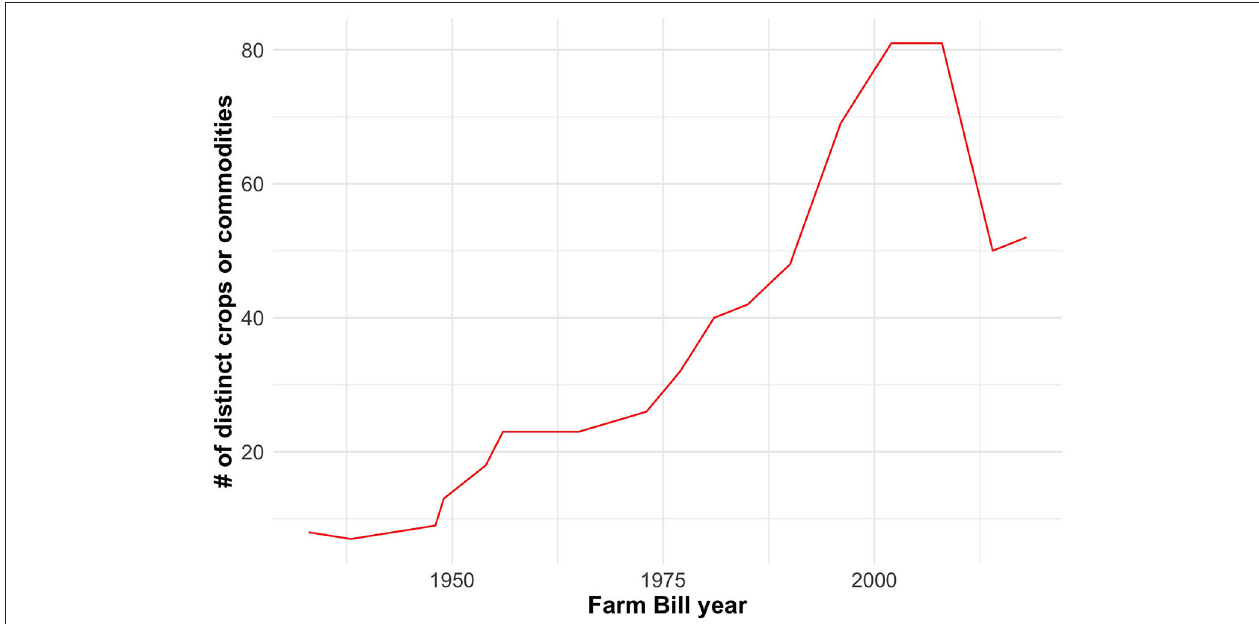
FIGURE 12 | Number of distinct crops or commodities included in the Farm Bill Commodities, Trade, Credit, and Crop Insurance Titles (i.e., commodity-focused Titles). Data: U.S. Farm Bills.